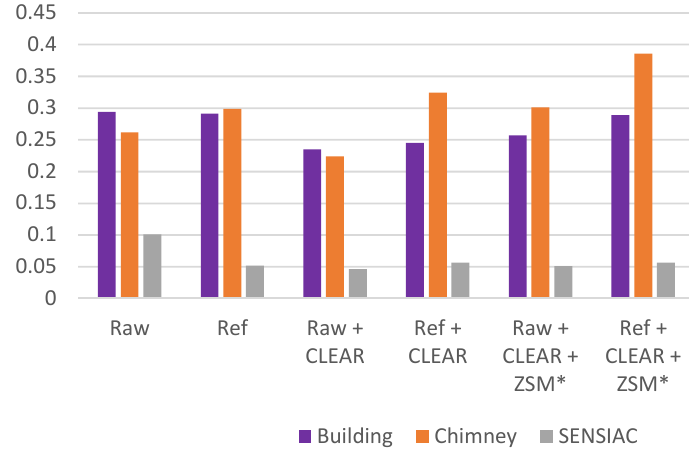
Figure 11. Bar charts depicting the contents in Table 6. VIIDEO score for all three sequences (a) VIIDEO Metrics and Rankings for Building and Chimney Videos